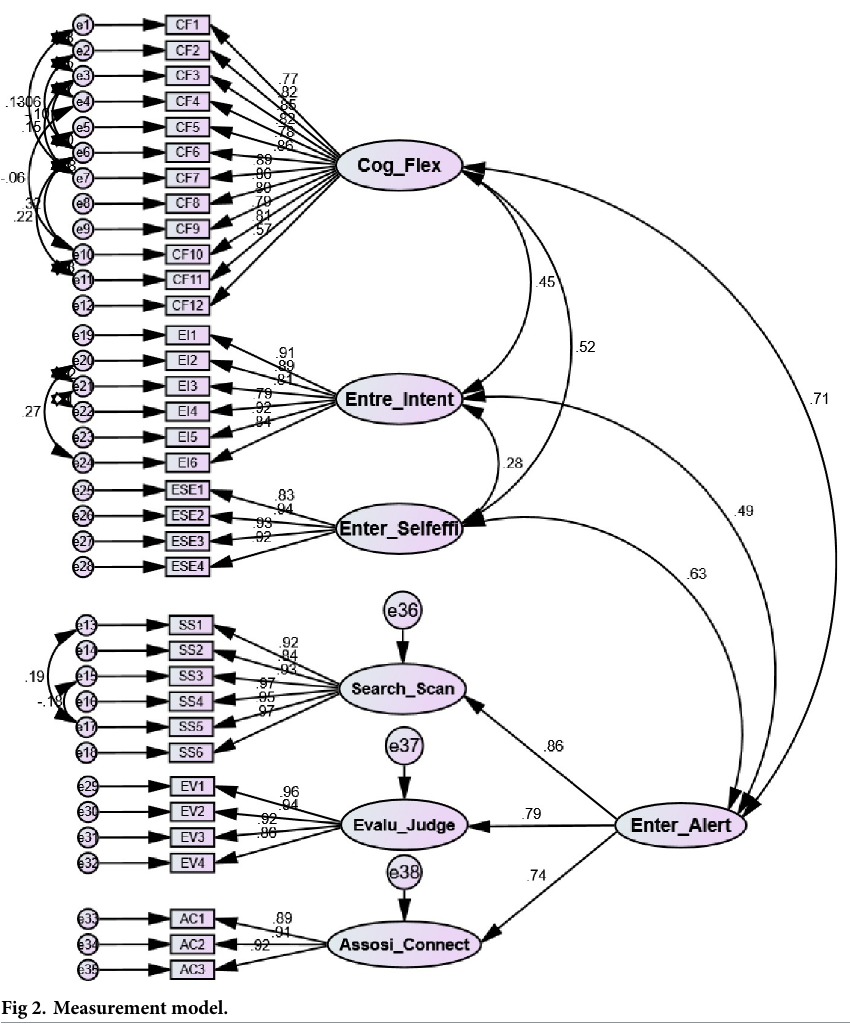
Fig 2. Measurement model.